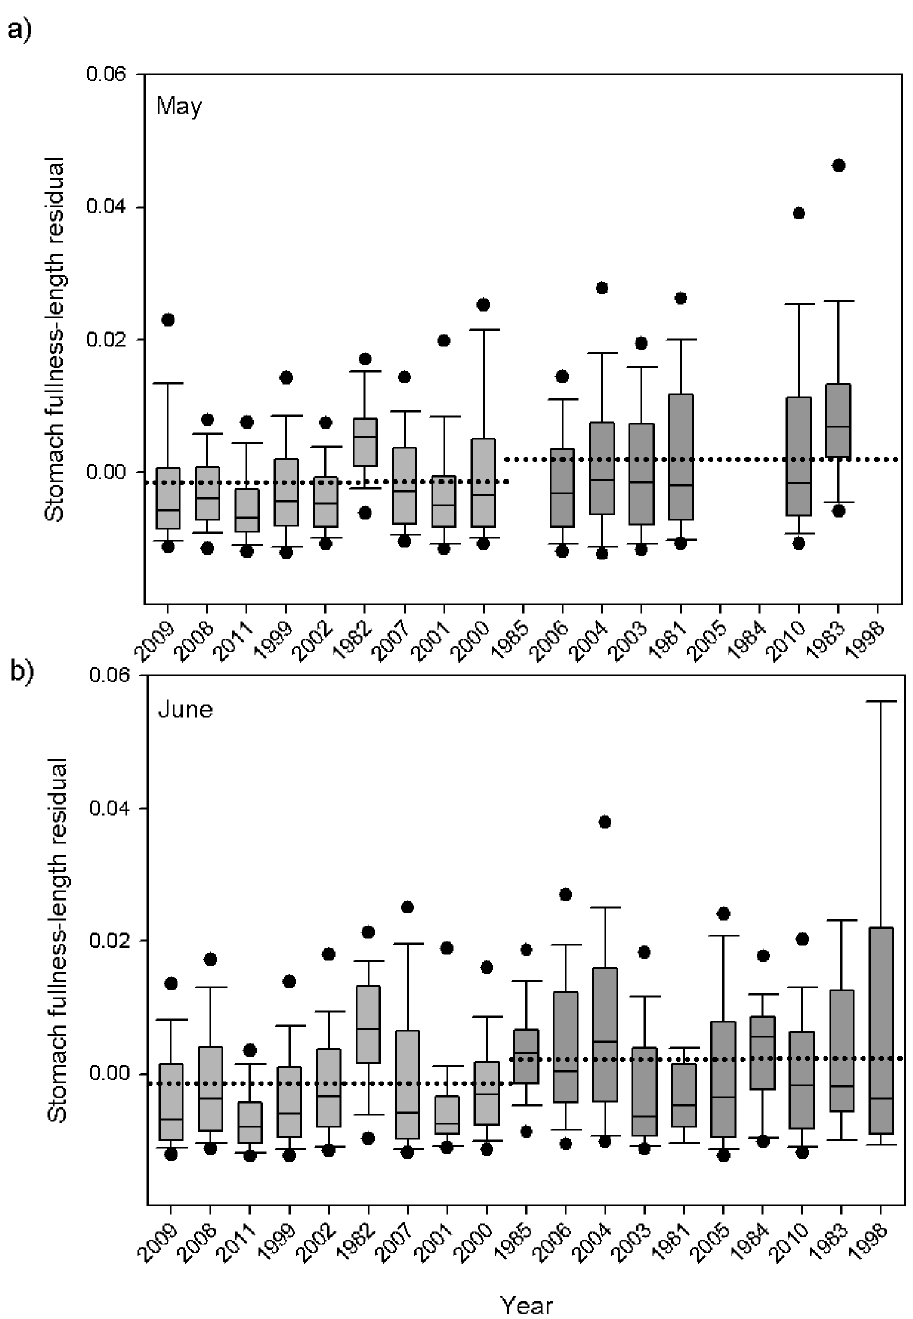
Fig 3. Average annual index of stomach fullness for May (a) and June (b) of juvenile yearling Chinook salmon. Shown are boxplots with the median (lines in boxes), 25th and 75th percentiles (lower and upper ends of boxes), 10th and 90th percentiles (error bars), and 5th and 95th percentiles (points) for each year. Light grey bars designate cold years, and darker grey bars designate warm years, with dotted line representing regime